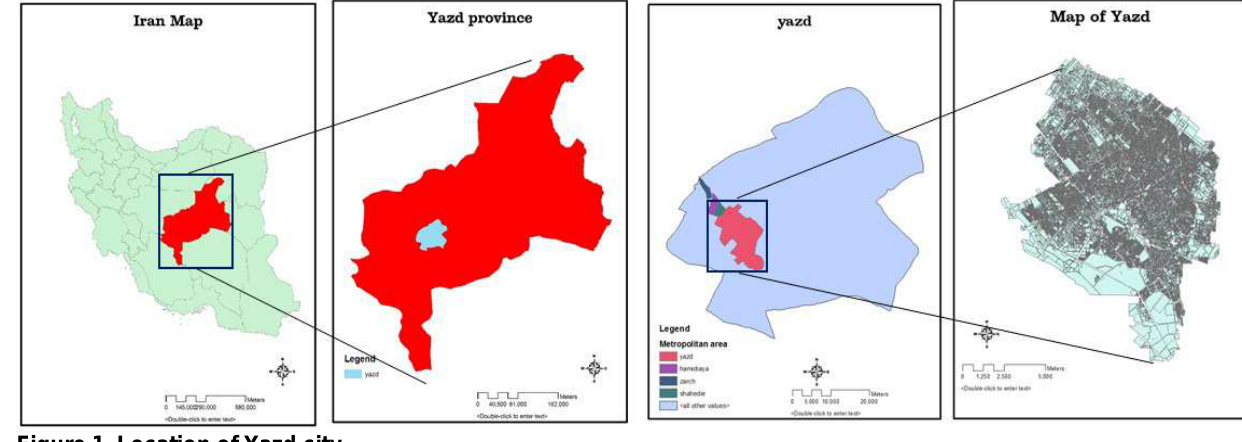
Figure 1. Location of Yazd city Table 1. Categorizing city land use zones and their definition